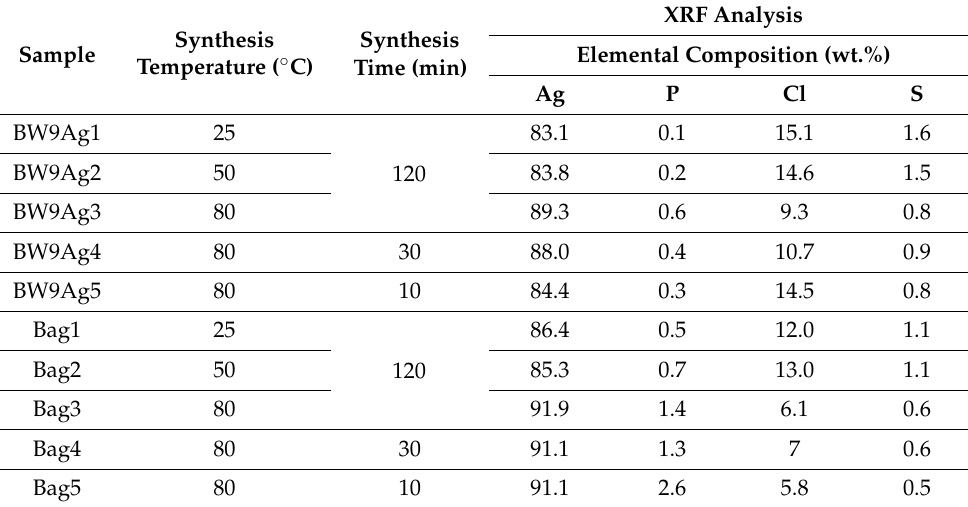
Table 3. Elemental composition of BW9 and B